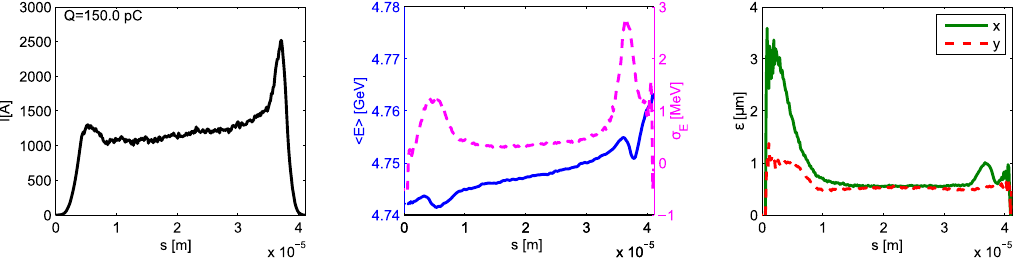
FIG. 6. Results from electron beam start-to-end simulations at the entrance of SASE undulator. From left to right: electron beam current, energy and energy spread, emittance along the beam.